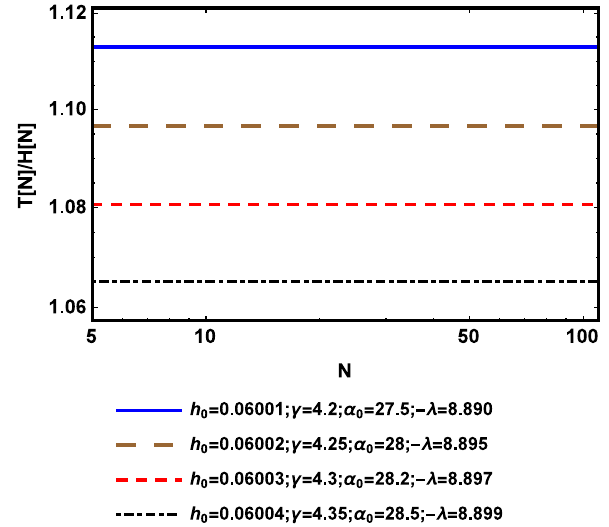
Fig. 8 The ratio of the temperature to the Hubble parameter during the inflationary evolution of the non-comoving warm inflationary model in the strong regime with generalized de Sitter scale factors, with n = 1, versus the number of e-folds, for different numerical values of the parameters of the model